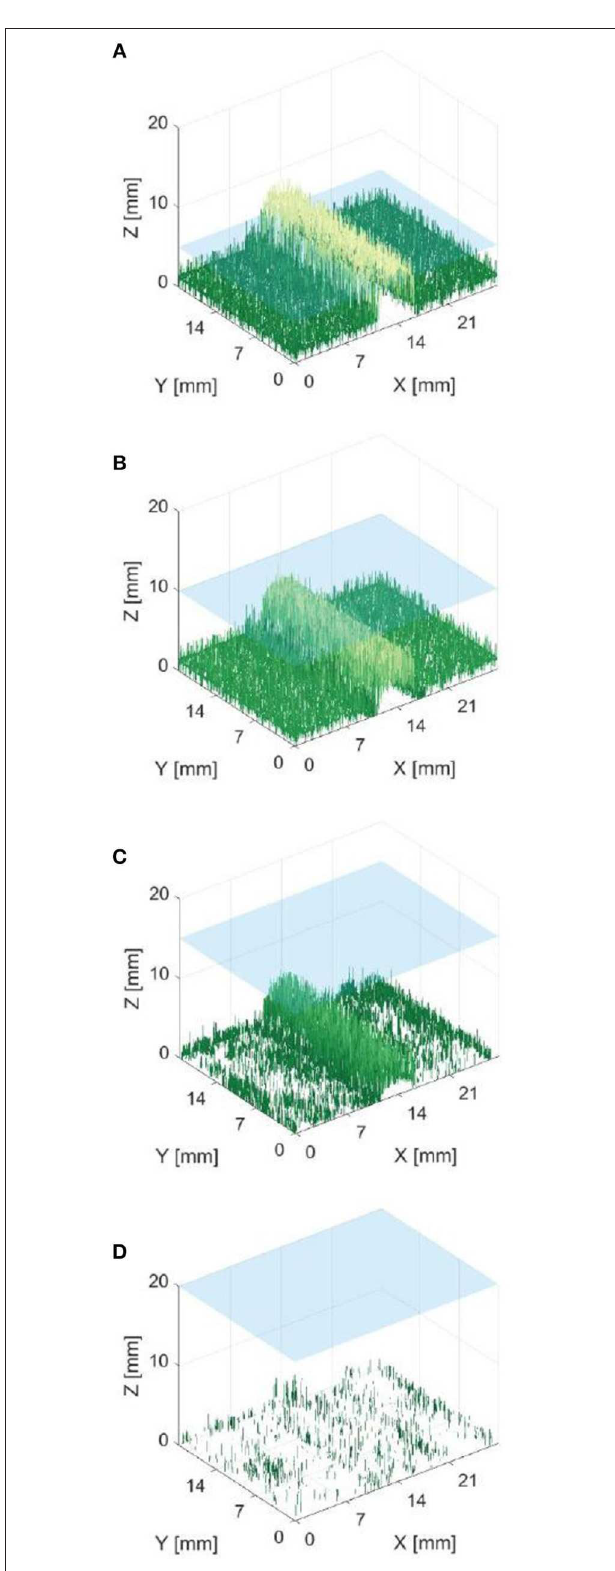
FIGURE 7 | Reconstructed depth maps for a capillary specimen submerged beneath 1, 6, 11, and 16mm (A–D) . Phantom surface shown in